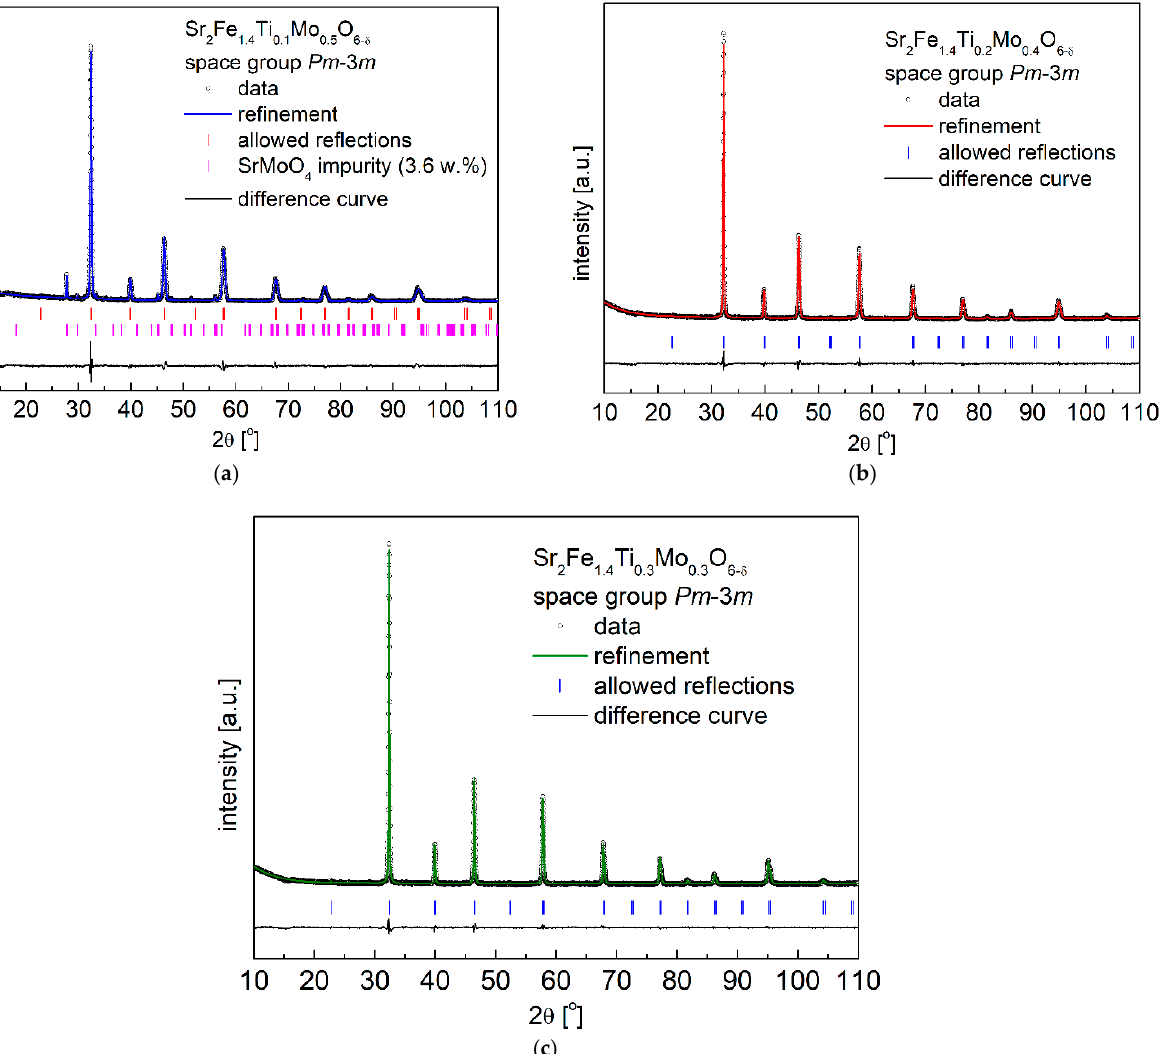
Figure 1. XRD patterns of the as-synthesized ( a ) Sr 2 Fe 1.4 Ti 0.1 Mo 0.5 O 6 − δ ; ( b ) Sr 2 Fe 1.4 Ti 0.2 Mo 0.4 O 6 − δ and ( c ) Sr 2 Fe 1.4 Ti 0.3 Mo 0.3 O 6 − δ samples. The redox stability of Sr 2 Fe 1.4 Ti x Mo 0.6 − x O 6 − δ (x = 0.1, 0.2 and 0.3) materials was stud- ied by annealing the compounds in 5 vol.% H 2 in Argon at 1200 ◦ C for 10h. The collected XRD data (Figure 2) after the reduction measurements show the reduced Sr 2 Fe 1.4 Ti x Mo 0.6 − x O 6 − δ still possess the same crystal structure ( Pm -3 m ), and the reduced B-site cations (Fe, Ti and Mo cations) with larger ionic radius contribute to a larger unit cell parameter a and volume V (see Table 1). Interestingly, among all investigated Sr 2 Fe 1.4 Ti x Mo 0.6 − x O 6 − δ materials, Sr 2 Fe 1.4 Ti 0.1 Mo 0.5 O 6 − δ oxide presents the smallest relative volume change ∆ V = 0.52% be- tween the reduced and oxidized samples. This indicates the possible application of such a compound in oxidizing and reducing conditions [54]. For comparison, the relative volume changes between the oxidized and reduced Sr 2 Fe 1.5 Mo 0.5 O 6 − δ and Sr 2 Fe 0.9 Mg 0.4 Mo 0.7 O 6 − δ oxides are larger and reach 1.18% [30] and 0.55% [34], respectively. The increase of Ti-doping in Sr 2 Fe 1.4 Ti x Mo 0.6 − x O 6 − δ (x = 0.2 and 0.3) leads to a significantly large volume change ∆ V , which can contribute to larger thermal expansion coefficients (TEC) in reducing and oxidizing